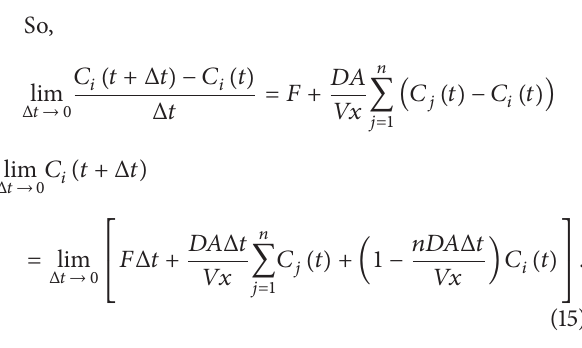
Figure 5: Subspace 𝑔 𝑖 surrounded by 𝑔 1 ,𝑔 2 ,...,𝑔 𝑛